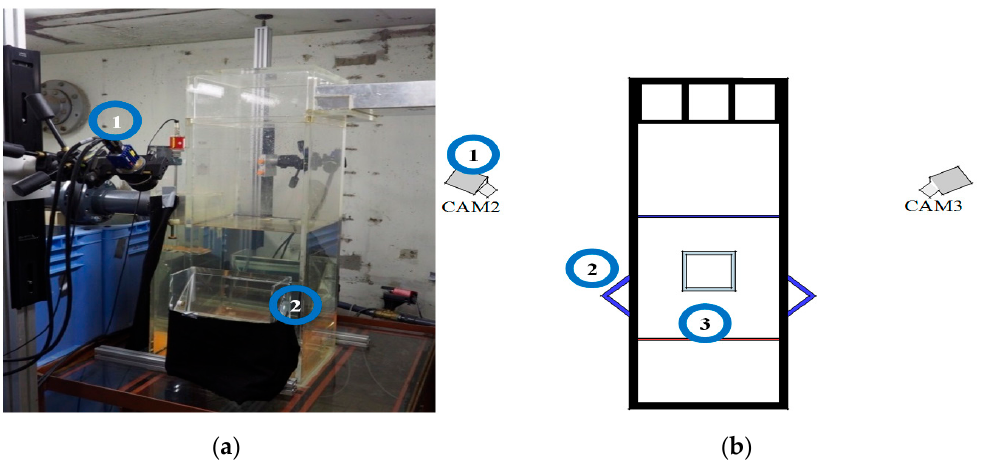
Figure 3. Camera setup for Stereo Particle Image Velocimetry (SPIV). 1. Camera equipped with Scheimpflug adapter 2. Acrylate prism 3. Plane of Interest (POI). ( a ) Photo of the setup; ( b ) Schematic drawing of the setup.